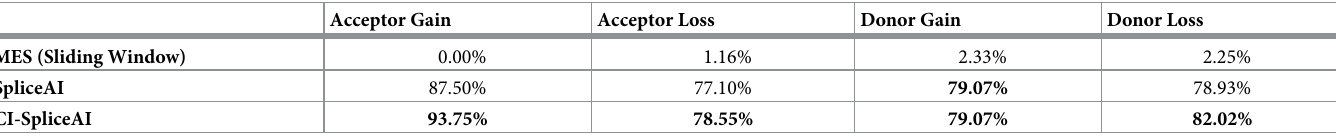
Table 3. Exact classification results on the curated variant